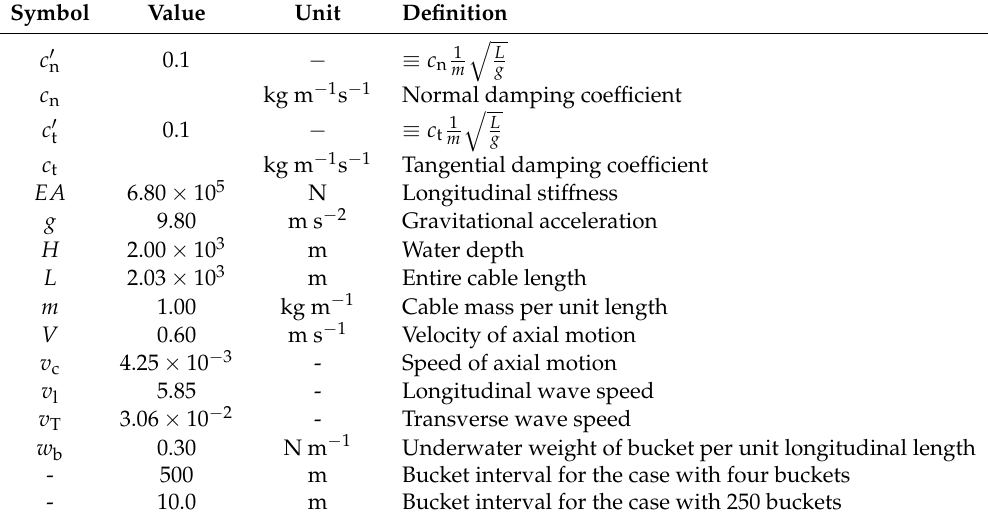
Table 1. List of